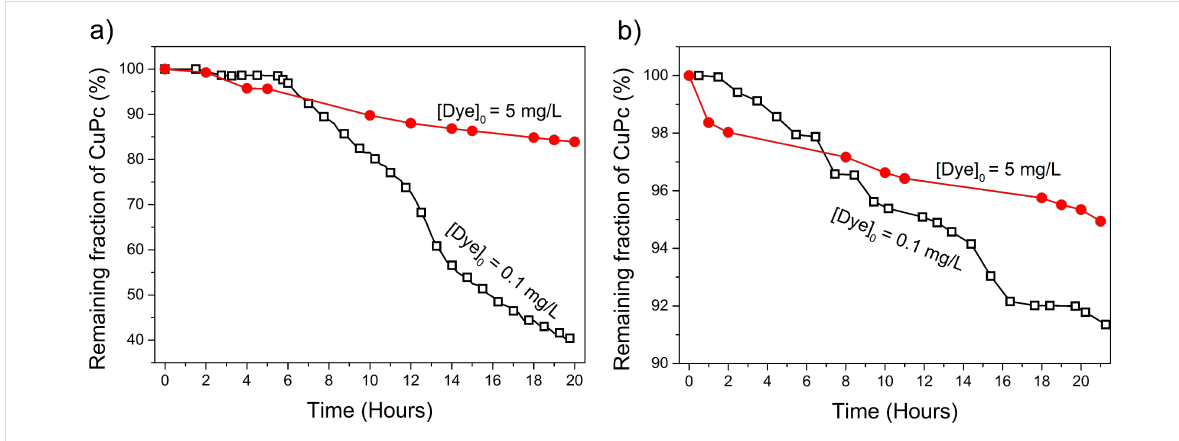
Figure 6: Decoloration rate at different initial concentrations of CuPc in suspensions of pyrite a) nanoparticles or b) microparticles, at loadings of 0.08 g/L.